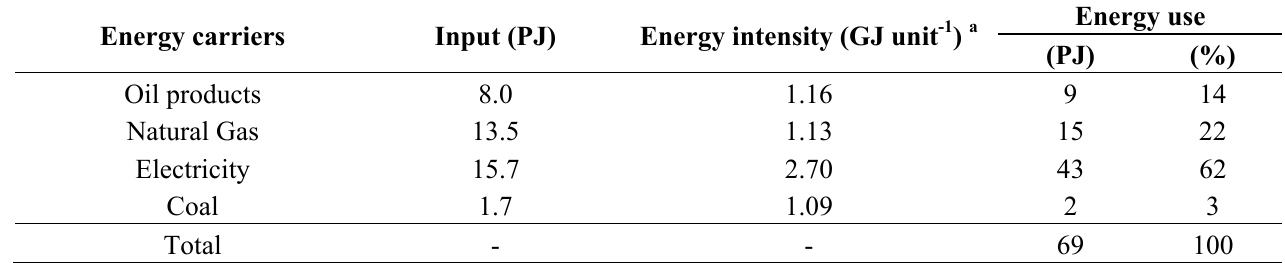
Table 4. Use of energy carriers in the Danish food manufacturing industry and corresponding direct and indirect fossil energy